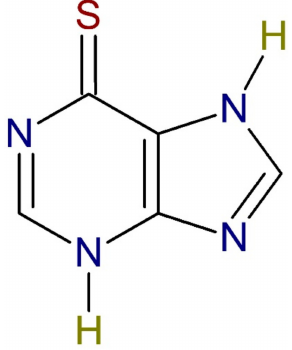
Figure 6. The 6-MP chemical structure.